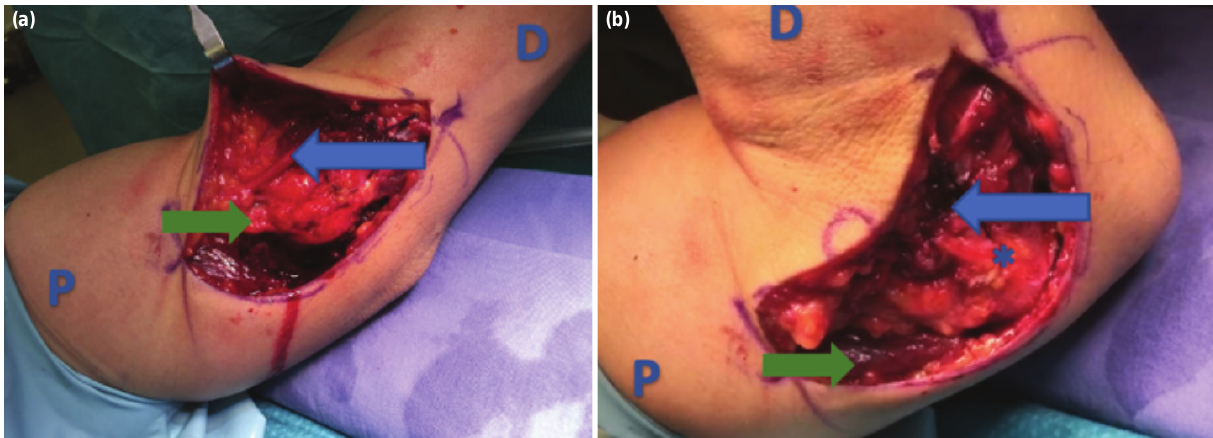
Transposition of the ulnar nerve performed using the submuscular technique. (a) The elbow at 20° flexion post fixation. (b) The Fig. 2: elbow at 90° flexion post fixation. (Blue arrow: represent the ulnar nerve, Green arrow: the triceps medial head, and asterisks: the medial epicondyle. D: distal, P: